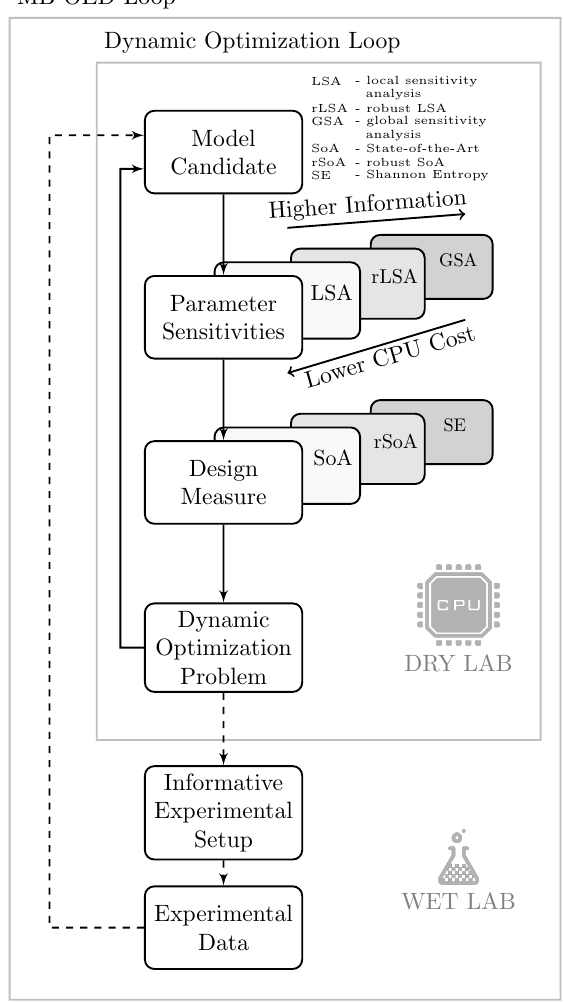
Figure 1. Key elements of the model-based optimal experimental design (MB-OED): the parameter sensitivity approach and the implemented design measure determine the quality of the designed experiment